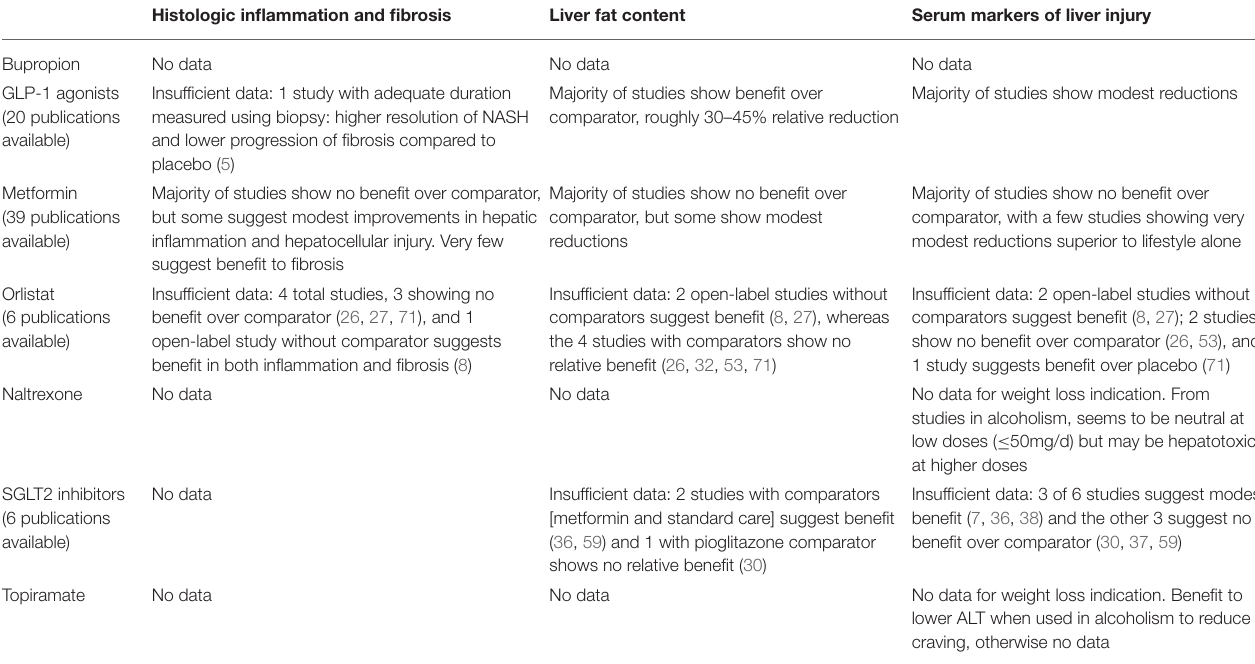
TABLE 2 | Summary of literature—effects on hepatic endpoints. Histologic inflammation and fibrosis Liver fat content Serum markers of liver injury Bupropion No data No